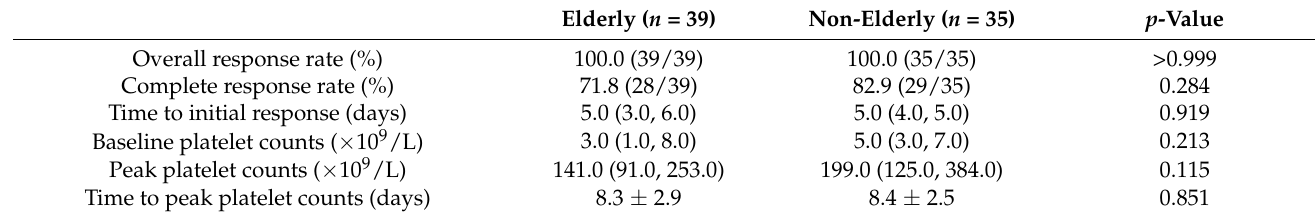
Table 3. Comparison of short-term efficacy in elderly and non-elderly